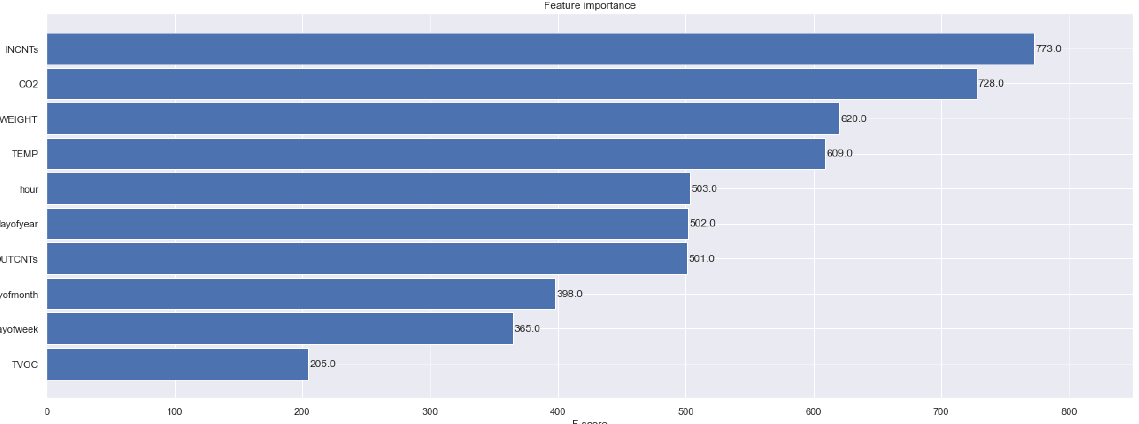
Figure 19. Feature importance on the regression task of forecasting the humidity level inside the beehive using gradient boosting trees (XGBoost). Table 3. Error metrics for the humidity